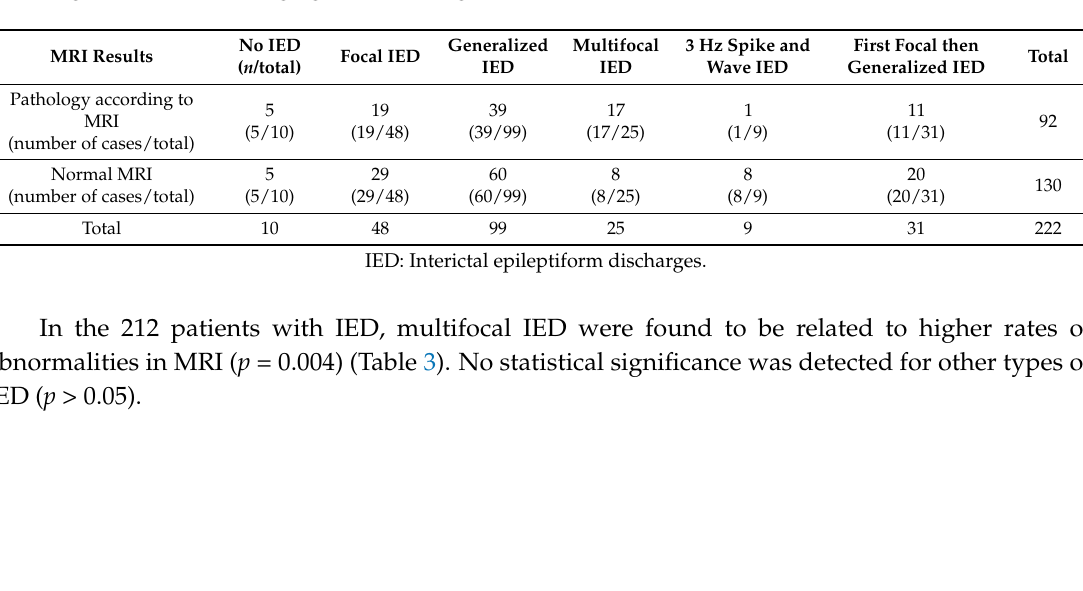
Table 2. Electroencephalography (EEG) findings in relation to the presence of abnormalities based on magnetic resonance imaging (MRI)